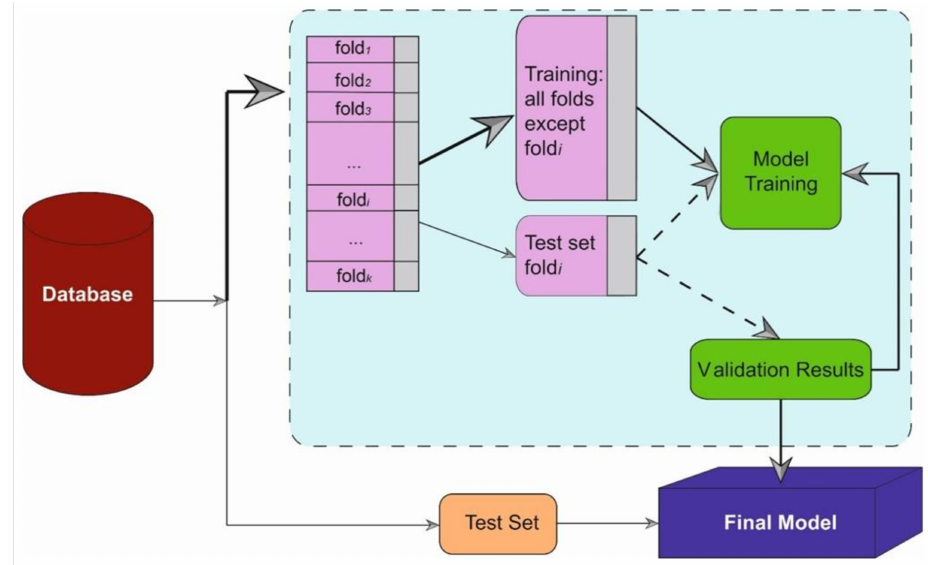
Figure 1. The figure shows the scheme followed in the learning and testing process of this